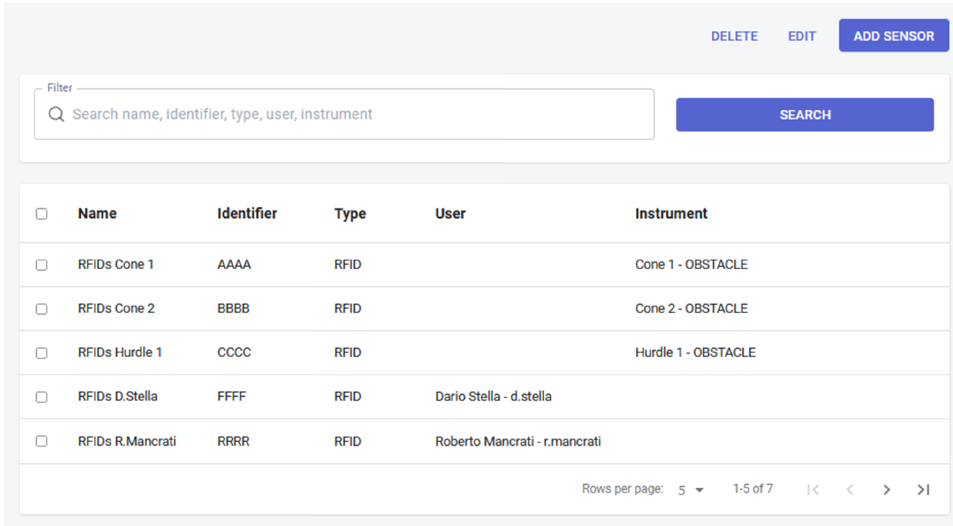
Figure 17. Sensors tab of the Front-end